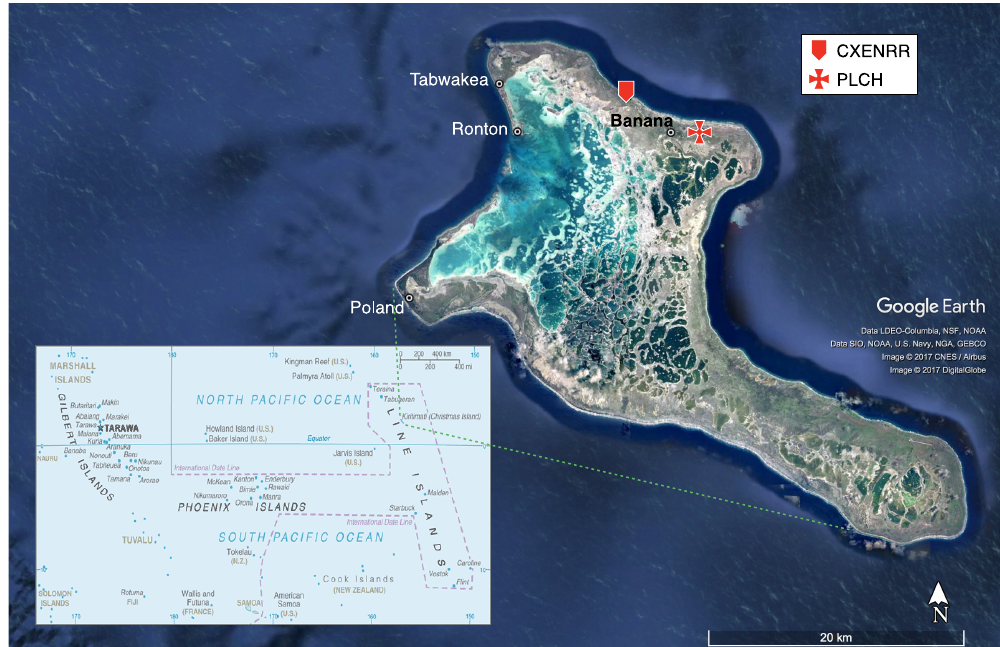
Figure 1. Composite satellite photo of Kiritimati showing the location of the four population centers, Cassidy International Airport (Inter- national Civil Aviation Organization (ICAO) airport code PLCH), and the ENRR field site (CXENRR). The inset map shows Kiritimati’s location within the Line Islands and the Republic of Kiribati in general. Kiribati map by the U.S. Central Intelligence Agency courtesy of the University of Texas Libraries, The University of Texas at Austin. Station symbol colors from www.ColorBrewer.org by Cynthia A. Brewer, Geography, Pennsylvania State University.